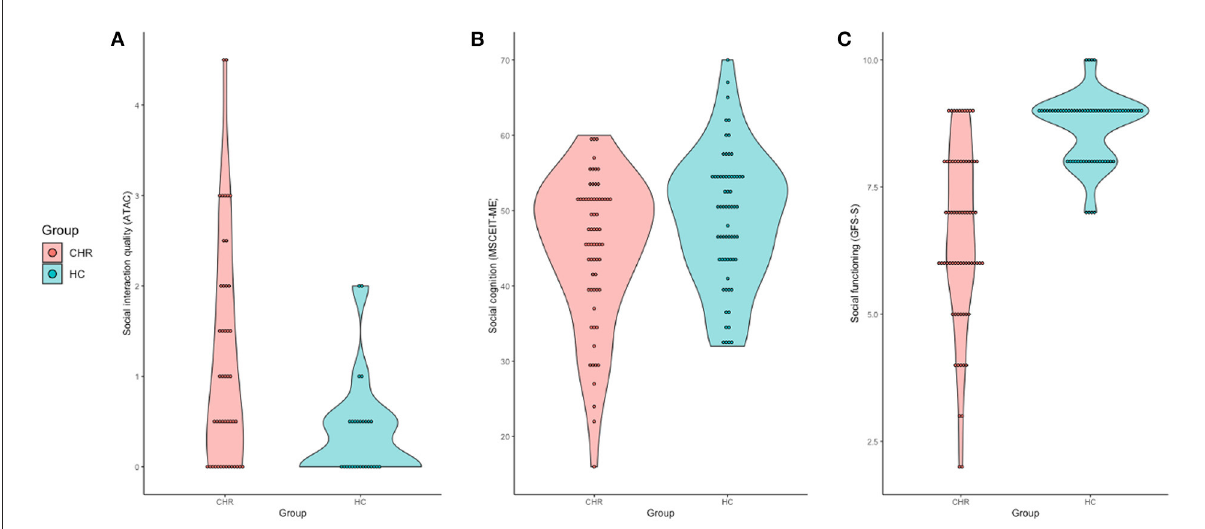
FIGURE1 Violin plots of group differences between behavioral social ability measures. (A) Social interaction quality, measured by the ATAC plotted by group. (B) Social cognition scores as measured by the MSCEIT-ME plotted by group. (C) Social functioning ability, measured by the GFS-S plotted by